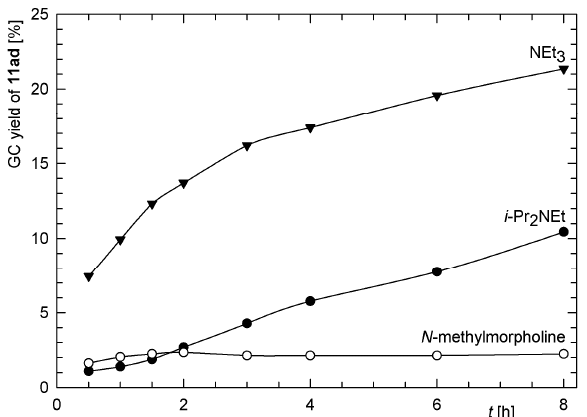
Figure 1. Kinetic profiles for the model coupling reaction performed in neat amines (0.5 mol.% catalyst 5 , 5 mol.% CuI) at 50 °C. Solid lines are added as a visual guide.